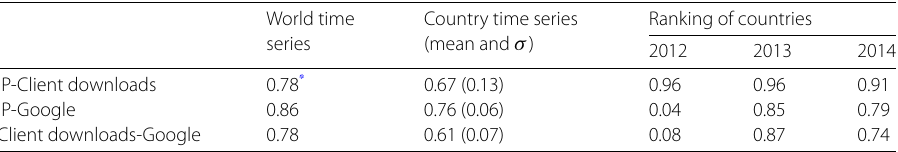
Table 4 Correlation between Google Trends time series, number of unique IPs and Bitcoin client downloads. Here we report correlations between the time-series at world level, and the average correlation at country level, during the period from March 2012 to May 2014. Moreover, selecting a period of one year we compute the Spearman correlation between the countries, ranked using the three proxies Ranking of countries World time Country time series series (mean and σ ) 2012